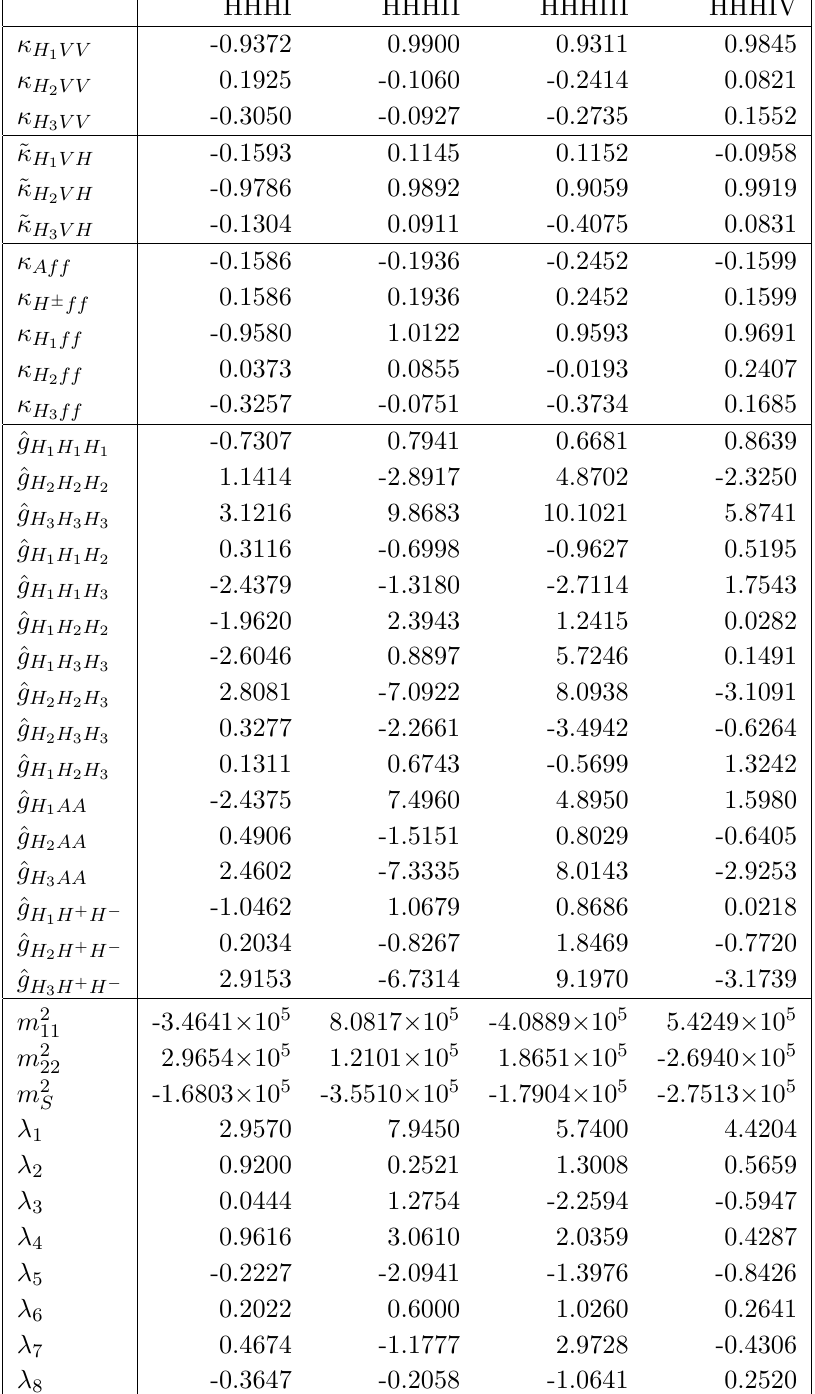
Table 14 . Higgs couplings to gauge bosons, fermions, and an illustrative subset of trilinear self-interactions, for the di(cid:11)erent benchmark scenarios used in the analysis of the decay modes H 3 ! H 2 H 2 and H 2 ! H 1 H 1 in section 7. The lowest rows display the values of the mass terms squared (in GeV 2 ) and quartic couplings in the Higgs potential eq. (2.3). The corresponding input parameters are given in table